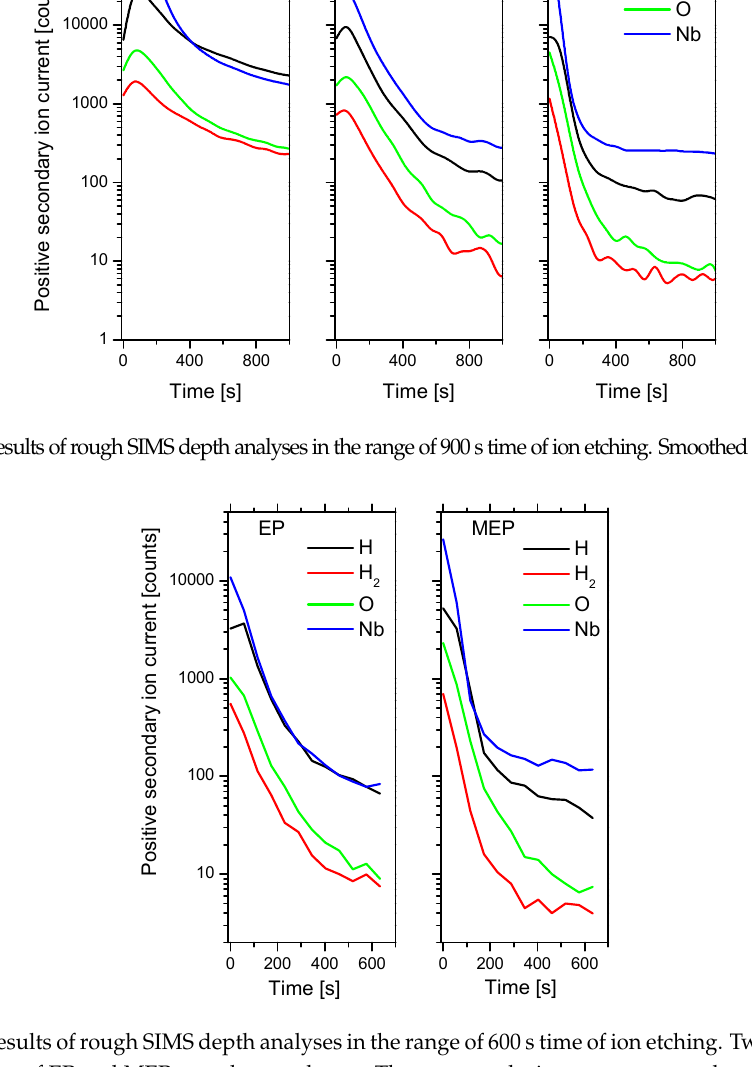
Figure 11. Results of rough SIMS depth analyses in the range of 600 s time of ion etching. Two additional measurements of EP and MEP samples are shown. The same analysis parameters used: scattering area: 3.5 mm × 3.5 mm, the analysis area: 1.35 mm × 1.35 mm.